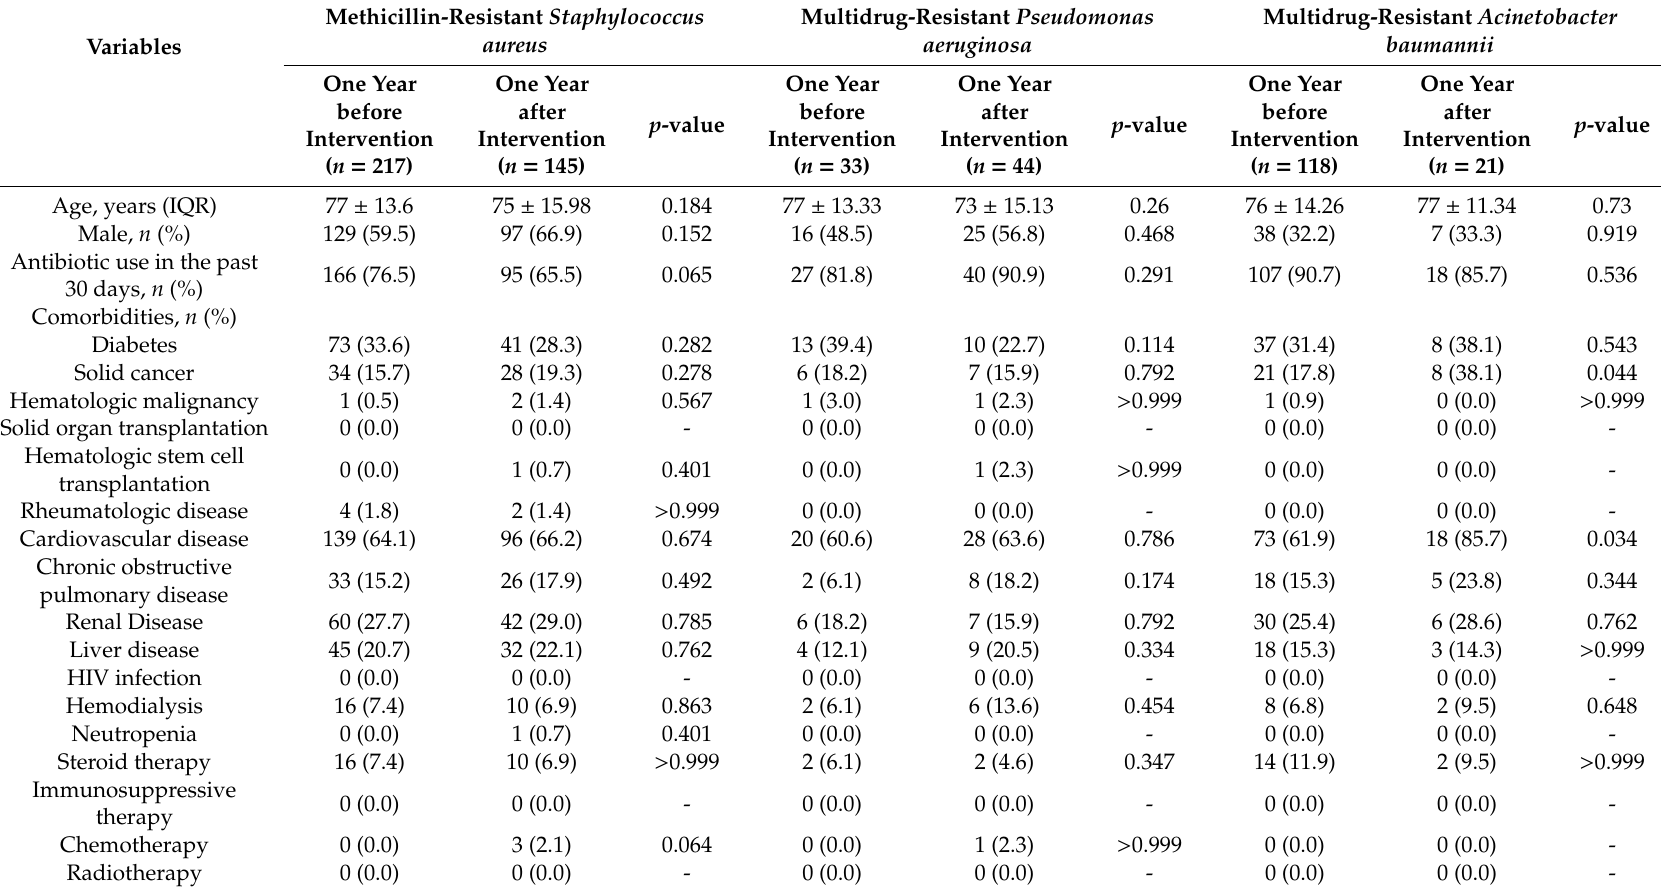
Table 1. Clinical characteristics of patients with hospital-acquired multidrug-resistant organisms between June 2016 and August